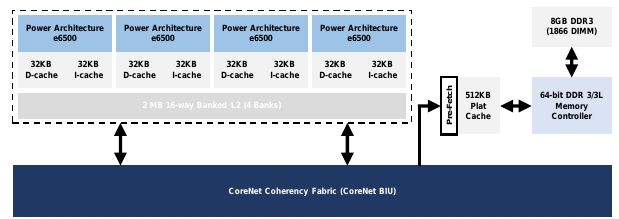
Figure 11. Architecture of